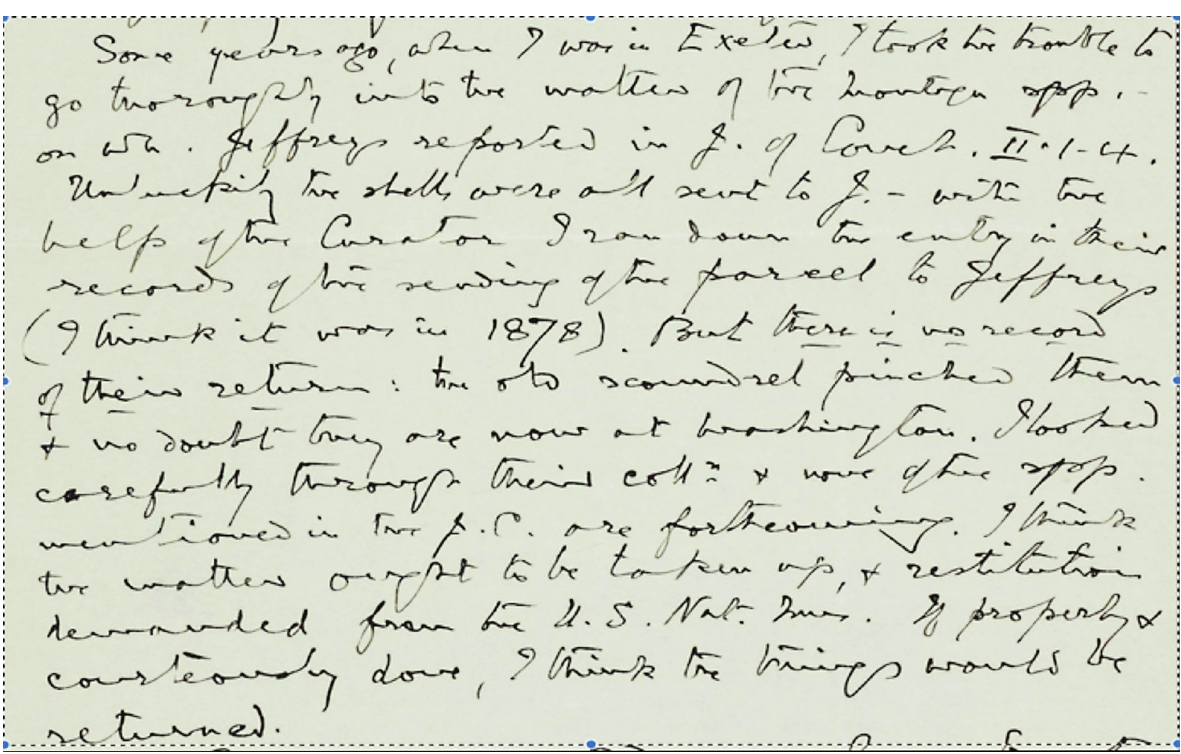
Figure 54. Part of a letter from J R Le B Tomlin to J D Dean concerning the fate of part of the Montagu collection in RAMM, Exeter; dated